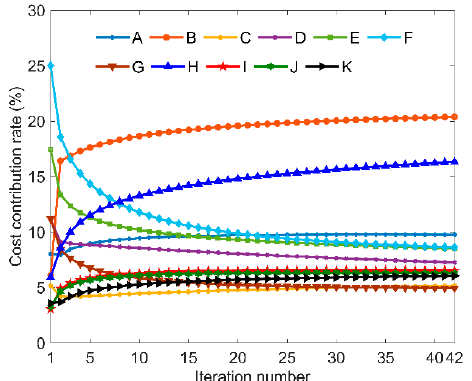
Figure 10. Variation of cost contribution rates.